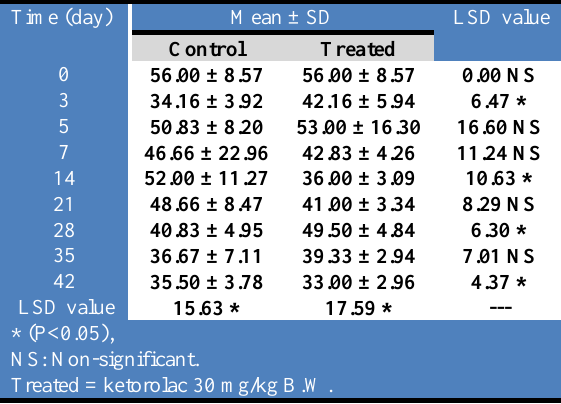
Table, 10: Shows Neutrophils (%) in control and ketorolac treated rabbits..